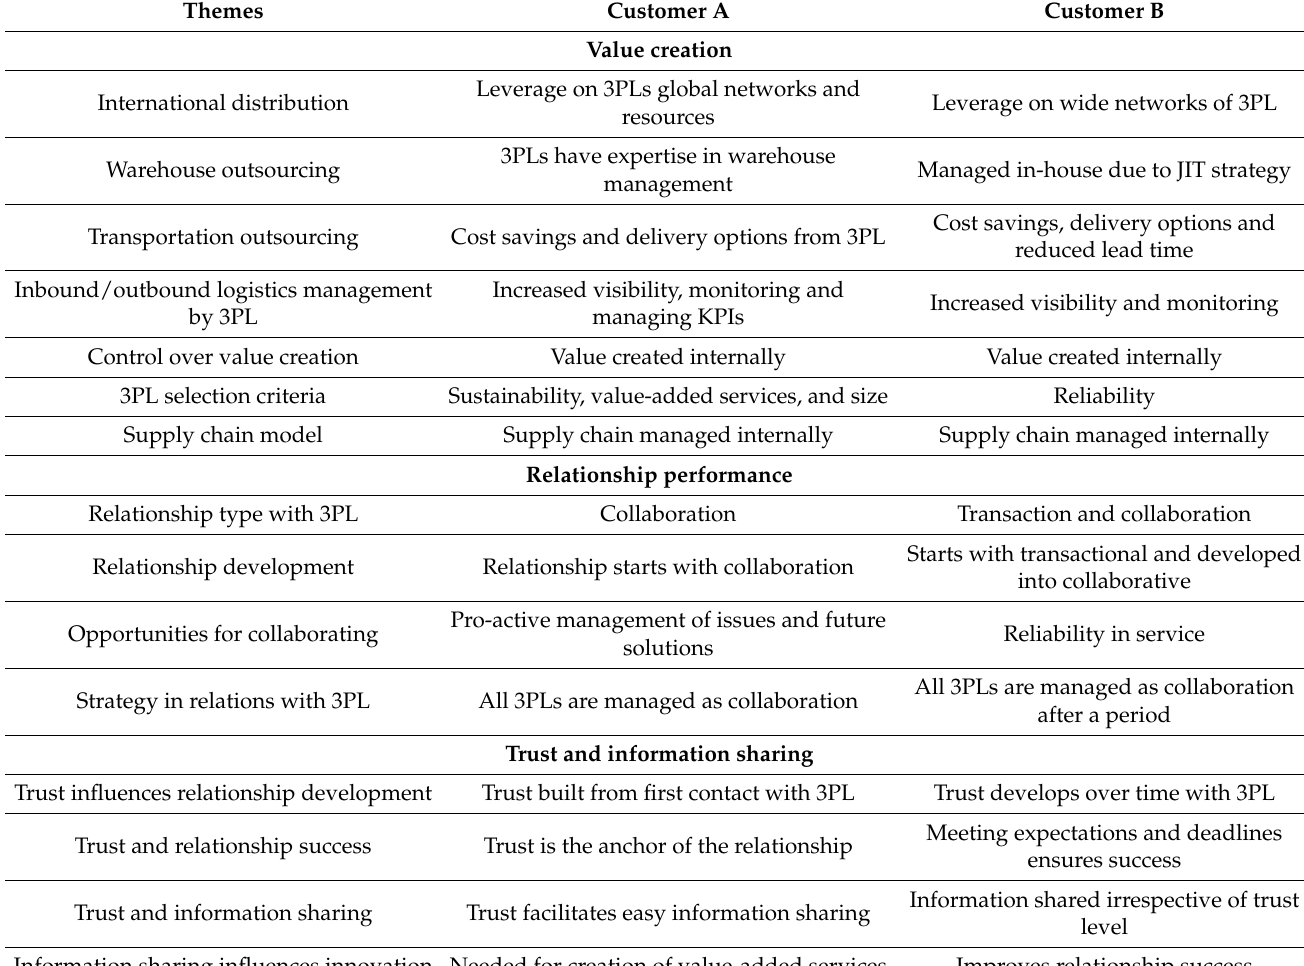
Table 2. Comparative analysis of users of